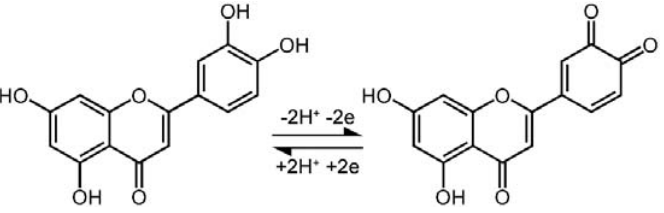
Figure 5. Electrochemical reaction mechanism of luteolin.